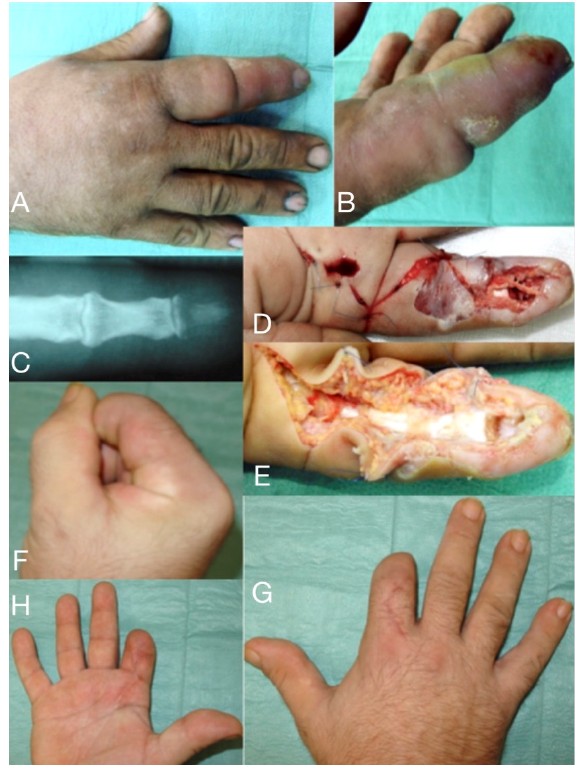
Figure 1. 66-year-old male, seven days after a wood-thorn puncture in the index fingertip ( A , B ). Severe infection expanded to tenosynovitis, osteomyelitis of the distal phalanx ( C ), and septic arthritis of DIP joint. After debridement ( D , E ) viable tissue was left only in the proximal half of the index, which has been amputated ( F , G , H ) distal to the PIP joint.